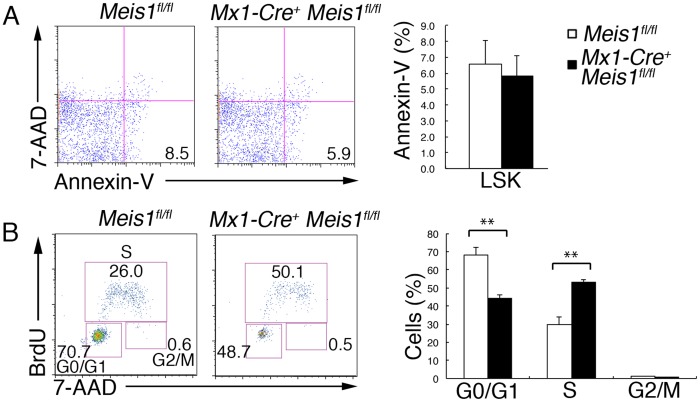
Meis1 regulates cell cycle of the HSC compartment.(A) Representative flow cytometric profiles showing Annexin V and 7-AAD staining of LSK cells from Mx1-Cre+ Meis1
fl/fl and control mice one week after poly(I:C) treatment. Bar graphs on the right represent the percentages of apoptotic LSK cells (anexin V+ 7-AAD−) cells from poly(I:C)–treated Mx1-Cre
+
Meis1
fl/fl (solid bars) and control Meis1
fl/fl (open bars) mice (mean and SD; n = 3). (B) Representative flow cytometric profiles showing BrdU incorporation and 7-AAD staining of LSK cells from Mx1-Cre Meis1
fl/fl and control mice one week after poly(I:C) treatment. Bar graphs shown on the right represent the percentages of cells in G0/G1-, S- and G2/M-phase of the cell cycle in the LSK cell population from poly(I:C)–treated Mx1-Cre
+
Meis1
fl/fl (solid bars) and control Meis1
fl/fl (open bars) mice (mean and SD; n = 3). **p<0.01.